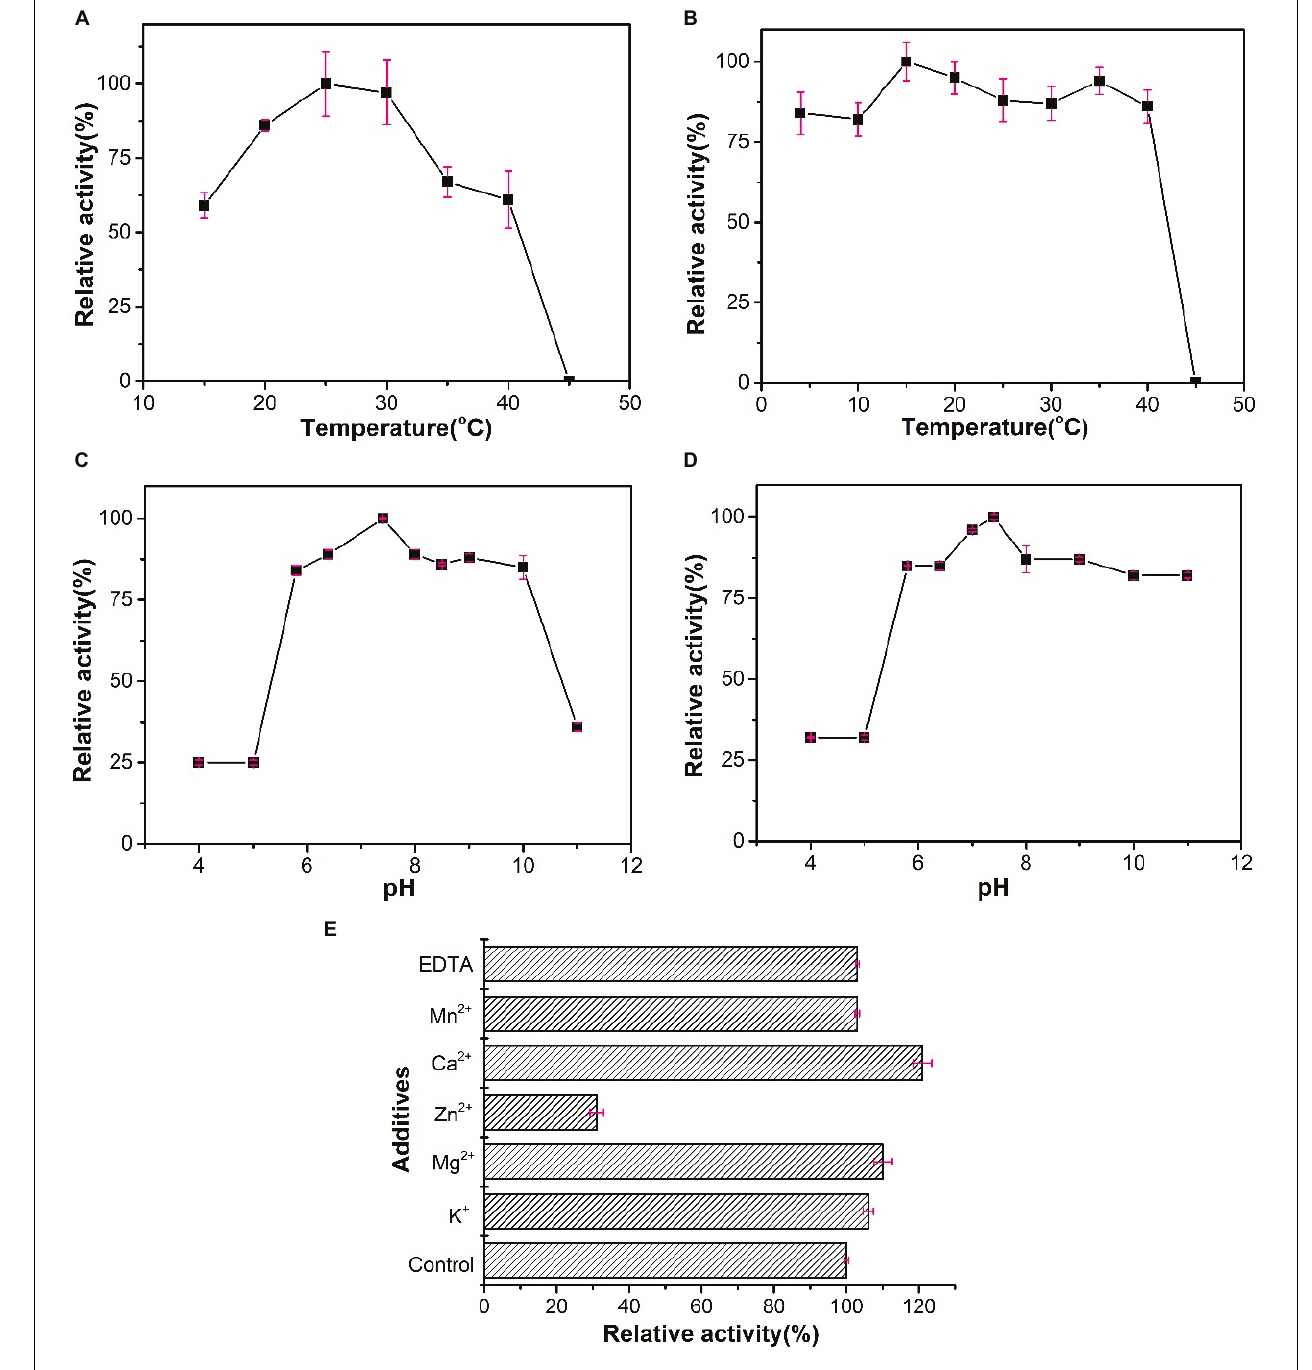
FIGURE 6 | Biochemical characterization of WelR. (A) Activity of WelR over a range of temperatures (15–45 ◦ C). Activity at 25 ◦ C was taken as 100%. (B) Thermal stability of WelR. Activity after being incubated at 15 ◦ C was taken as 100%. (C) Activity of WelR over a range of pH values (4–11). Activity in pH 7.4 buffer was taken as 100%. (D) The pH stability of WelR. Activity after being incubated in pH 7.4 buffer was taken as 100%. (E) Effects of various metal ions and EDTA on the activity of WelR. Activity in the blank control was taken as 100%. Values are presented as the mean ± SD; n = 3.